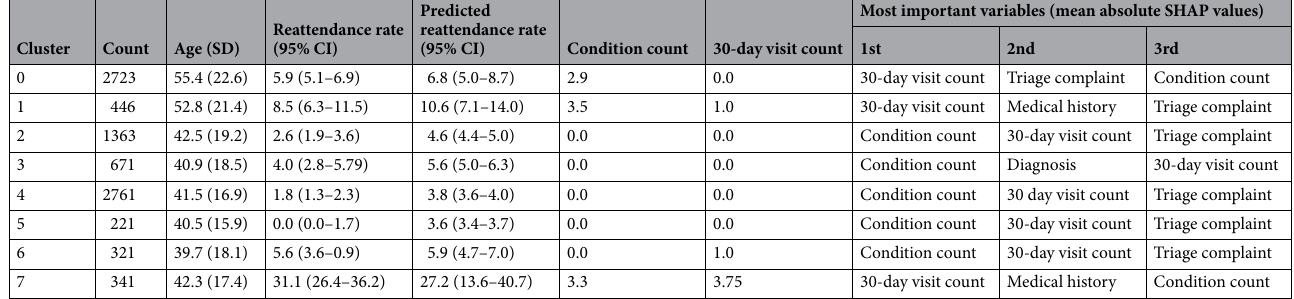
Table 4. Properties of the attendances assigned to each of the explanation clusters (Fig. 4). The count column displays the number of attendances in a given cluster. The age (in years), reattendance rate, predicted reattendance rate, condition count, and 30-day visit count column display the mean of the respective variable for all attendances in the cluster. Values in brackets in the age column display the standard deviation patient age in the respective cluster. The final three columns display the most important variables in making a decision, averaged across all attendances in a given